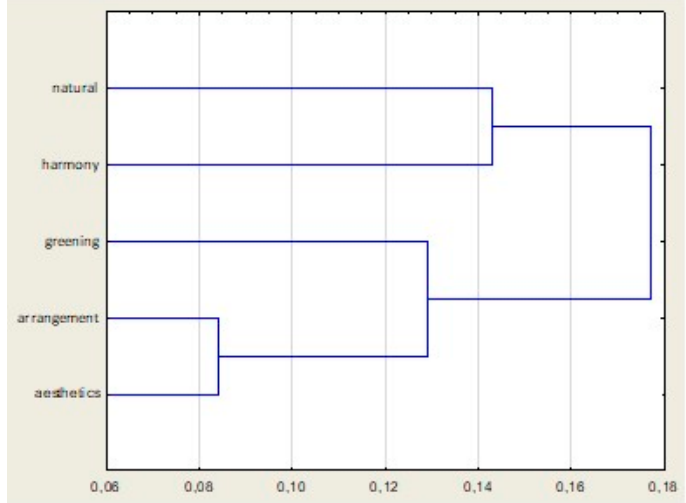
Figure 7. Grouping of the assessment indicators of the harmonious landscape (EnvEng and CivEng students combined, n = 244).